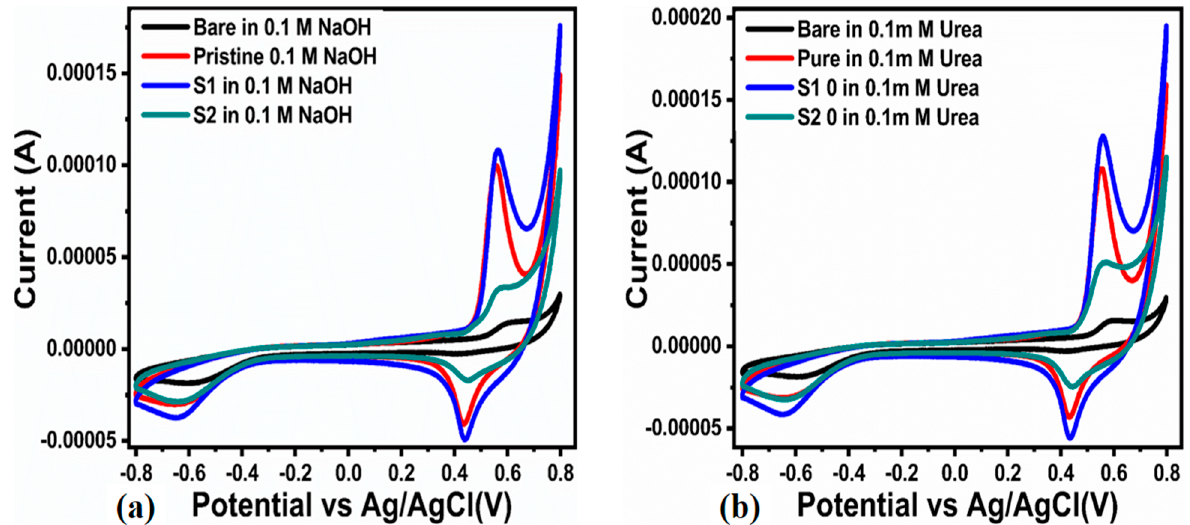
Figure 2. ( a ) Cyclic voltammogram of bare GCE and MGCE with pristine NiO and sample 1 and sample 2 of NiO nanostructures prepared with 10 mL and 15 mL of bitter gourd peel extract at 50 mV/s in 0.1 M NaOH, ( b ) cyclic voltammogram of bare GCE and MGCE with pristine NiO and sample 1 and sample 2 of NiO nanostructures prepared with 10 mL and 15 mL of bitter gourd peel extract at 50 mV/s in 0.1 mM urea.